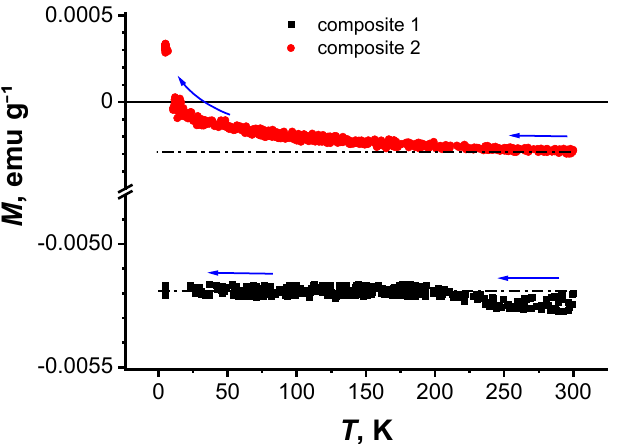
Figure 6. Temperature dependence of the magnetic moments for composites 1 and 2 in cooling at H = 500 Oe.